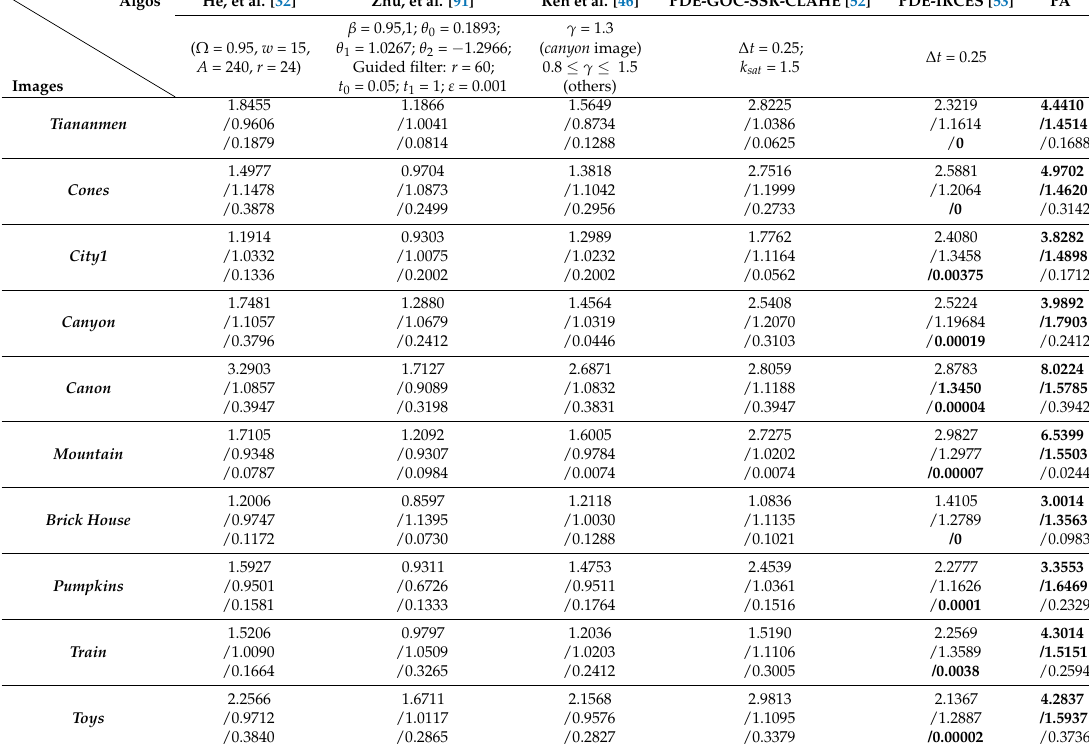
Table 2. RAG, ratio of visible edges, and saturation parameter values for images processed with He et al. [32], Zhu et al. [90], Ren et al., PDE-GOC-SSR-CLAHE [52], PDE-IRCES [53], and